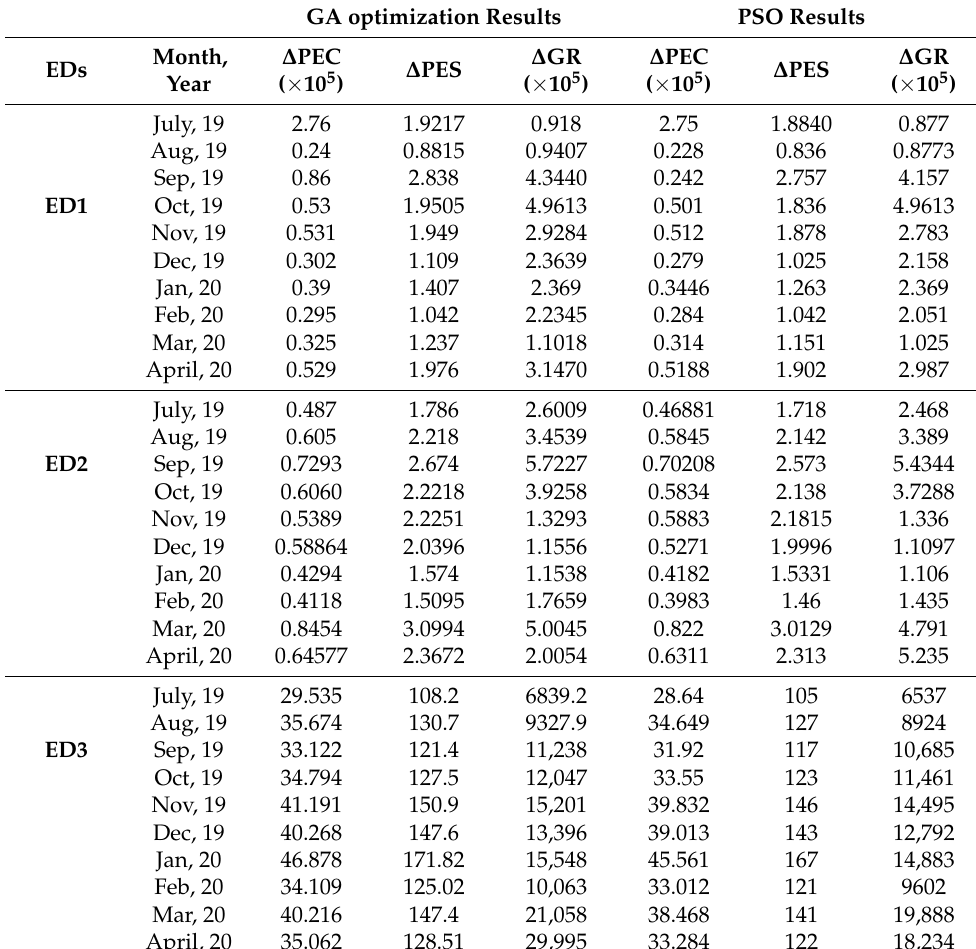
Table 4. Comparative analysis of GA and PSO optimized results.